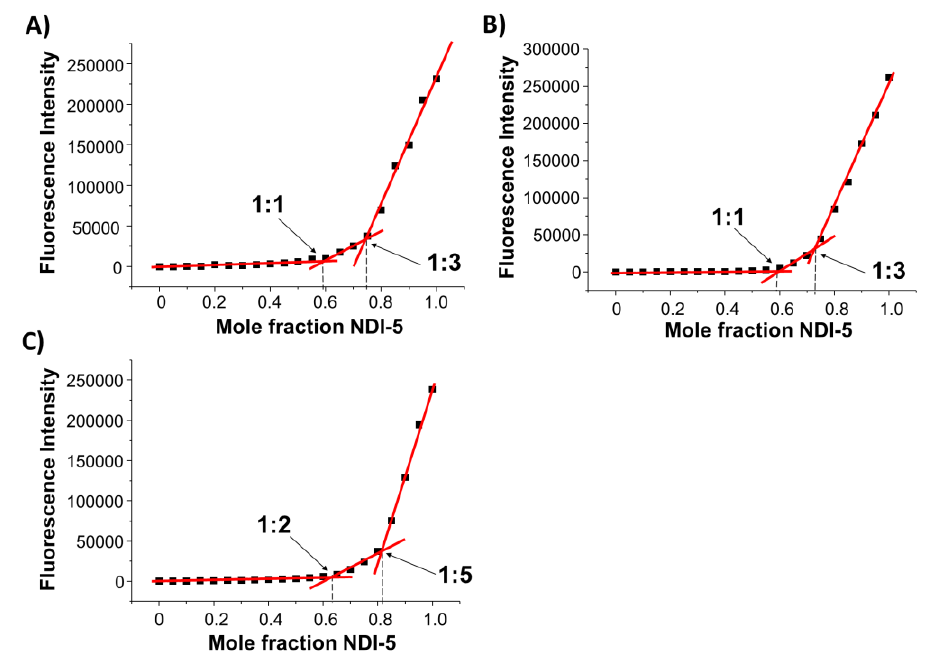
Figure 8. Job plot analyses for the binding of NDI-5 to ( A ) tel26, ( B ) cmyc and ( C ) ds27. The total molar concentration ([ligand] + [DNA]) was kept constant at 2 µM. The experiments were performed in 20 mM KCl, 5 mM KH 2 PO 4 and 10% DMSO buffer (pH 7). The excitation wavelength was 526 nm, and the here-reported fluorescence intensity was taken at 589